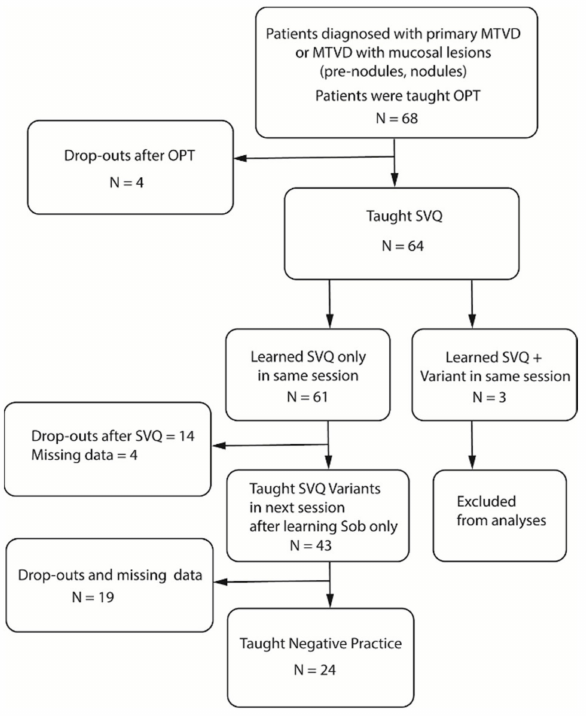
Figure 1. Flowchart of the treatment